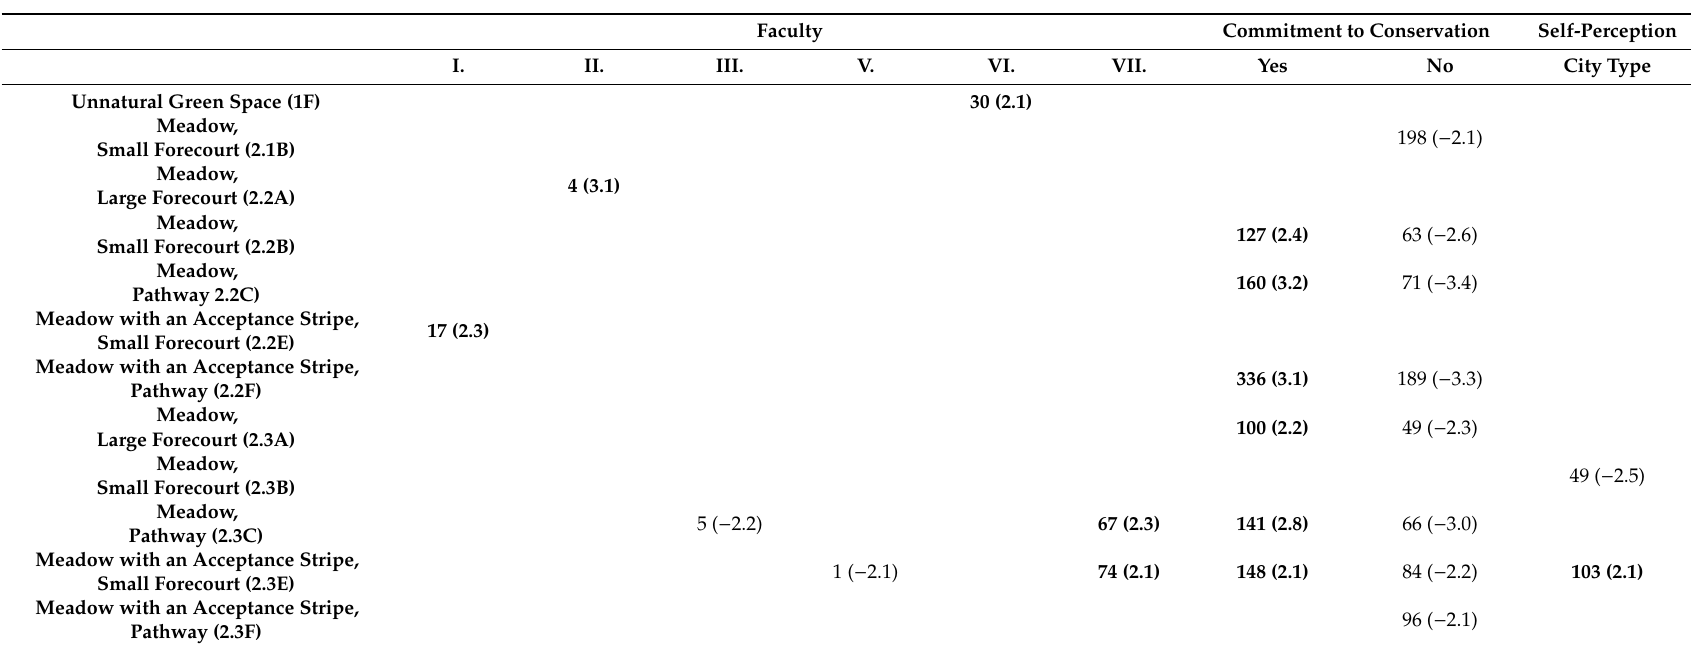
Table A4. Table of all the presented meadow areas that were significant with respect to faculties, commitment to nature conservation, and peoples’ self-perception. The table presents the number of choices for a certain green space by the respective sociodemographic group (standardized residuals in brackets). Whereas a positive residual indicates that the scenario was appreciated by the relevant demographic group (bold type), a negative residual indicates that the scenario was disliked (normal